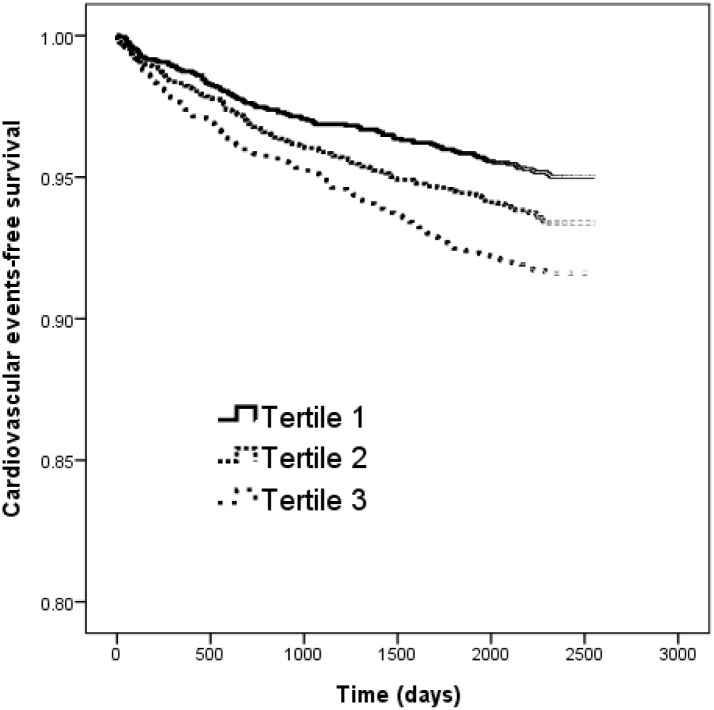
Kaplan-Meier analysis of cardiovascular events-free survival according to tertile of SD of HbA1c (log-rank p < 0.001) in patients with eGFR ≧ 60 min/ml/1.73m2.Diabetic patients with tertile 2 and tertile 3 of HbA1c SD had a worse cardiovascular events-free survival than those with tertile 1 of HbA1c SD.